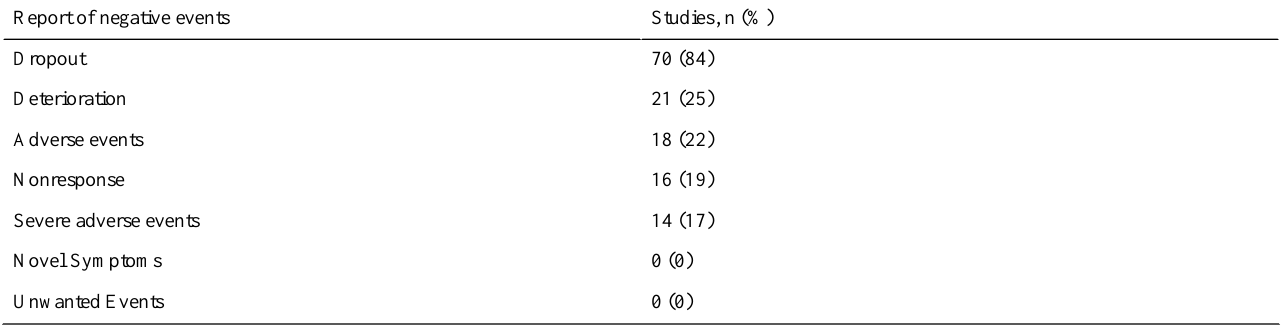
Table 4. Report of negative events in included studies (N=83).